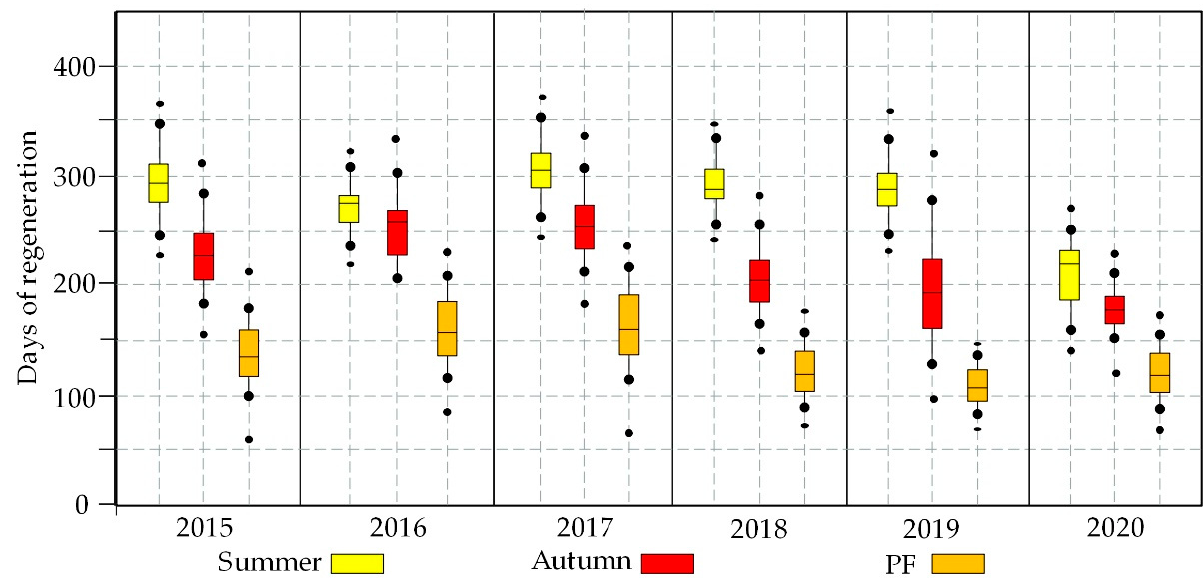
Figure 5. Analysis of days for vegetation recovery from fire using the NBR.